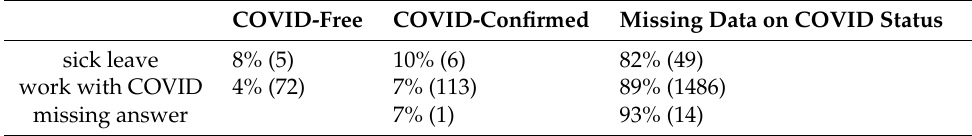
Table 3. Description of employees’ working status and COVID status ( n =